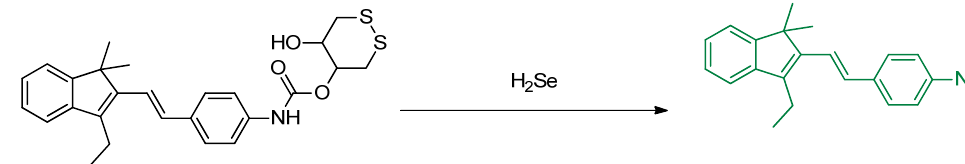
Figure 47. Structure of Hcy–H 2 Se and its action of undergoing reaction with and detecting H 2 Se by Kong et al. Areti et al. synthesized a fluorescence probe based on dansyl linked with